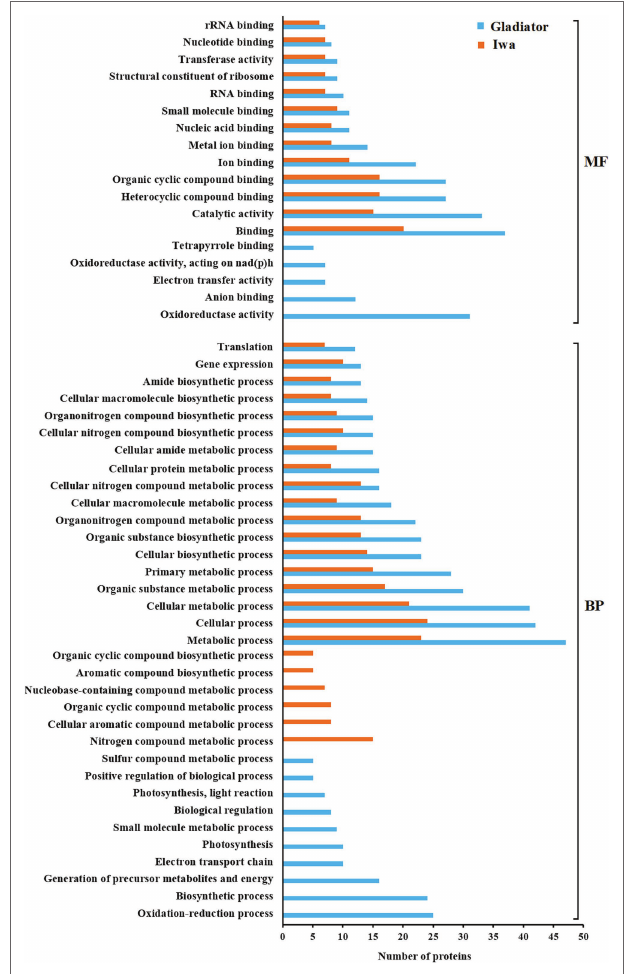
FIGURE 3 | Gene ontology (GO) enrichment analysis of the differentially abundant leaf proteins of potato plants (Gladiator and Iwa) with roots non- inoculated and inoculated by Spongospora subterranea . MF, molecular function; BP, biological